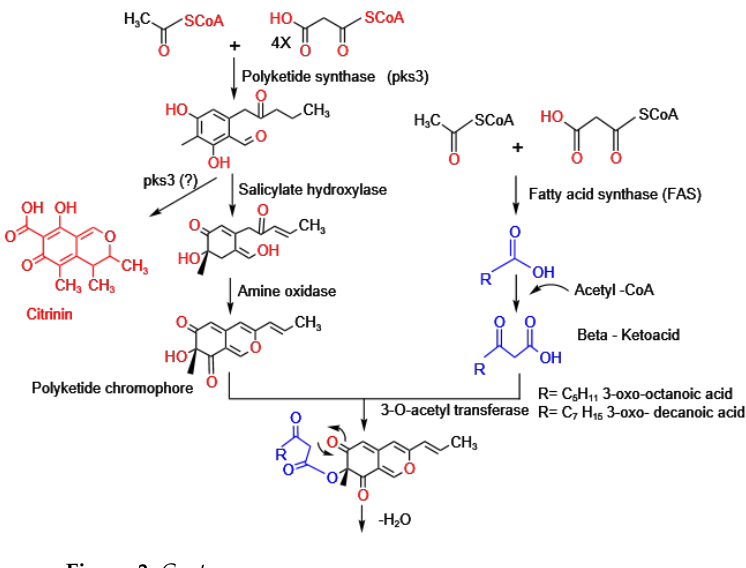
Figure 3. Hypothetical pathway of Monascus pigment and citrinin biosynthesis. The figure was re- produced following Woo and Chen [161,162].